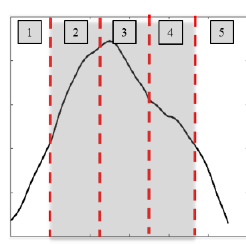
Fig. 3: Five equi-temporal regions of a contraction